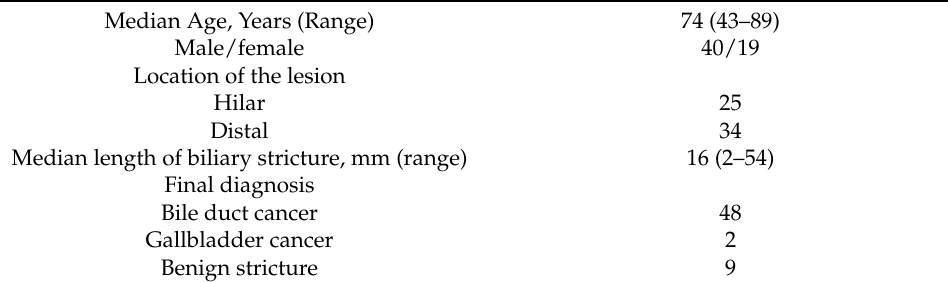
Table 1. Baseline characteristics of patients (N =